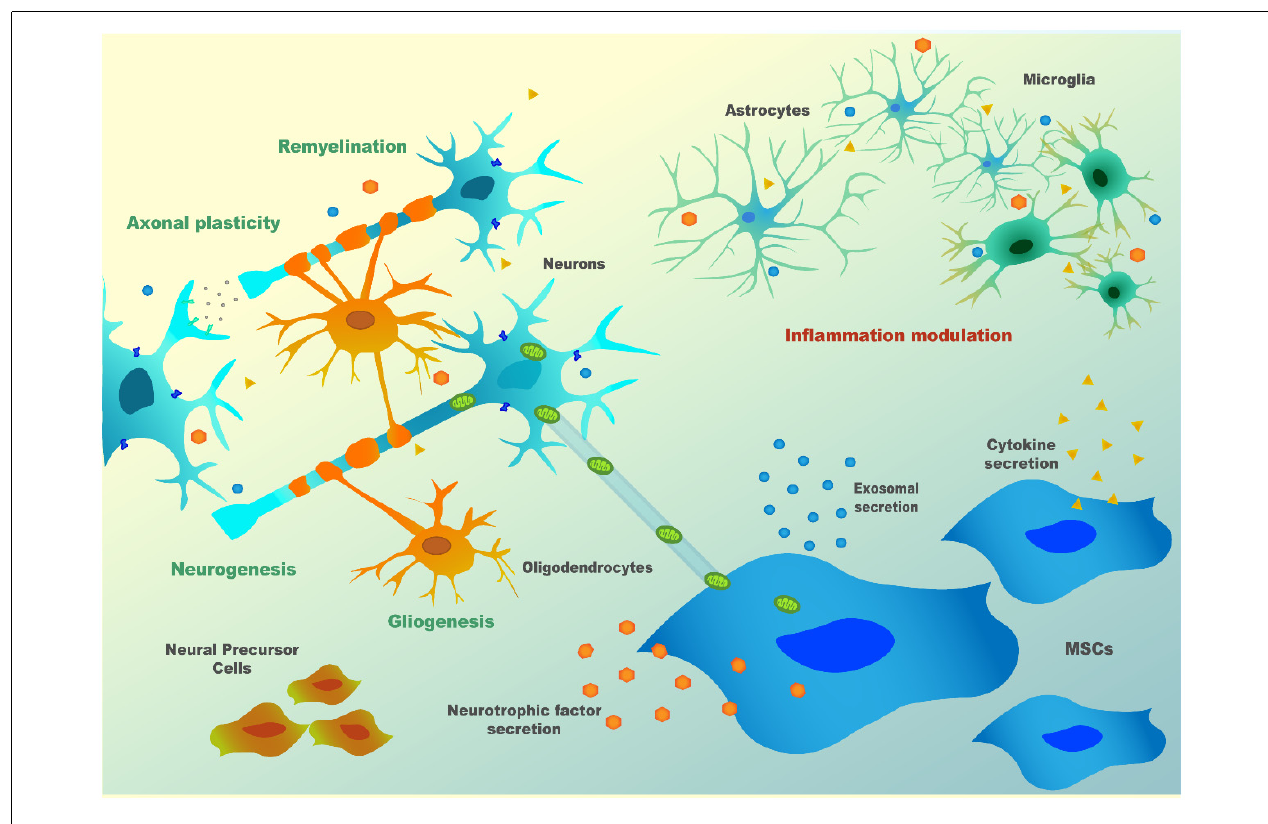
FIGURE 2 | MSC’s paracrine mechanism(s) in neuronal